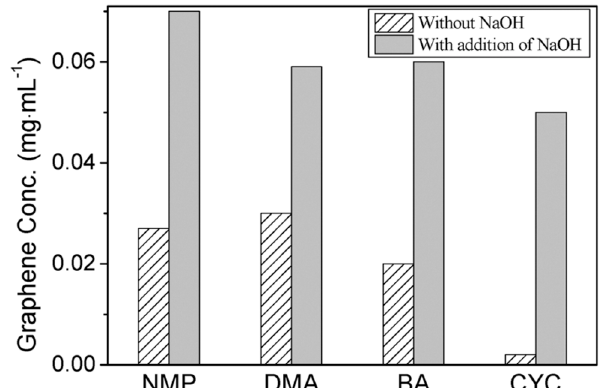
Figure 15. Concentrations of graphene sheets dispersed in organic solvents with or without addition of NaOH. Reproduced from [46]. Copyright Royal Society of Chemistry, 2011.